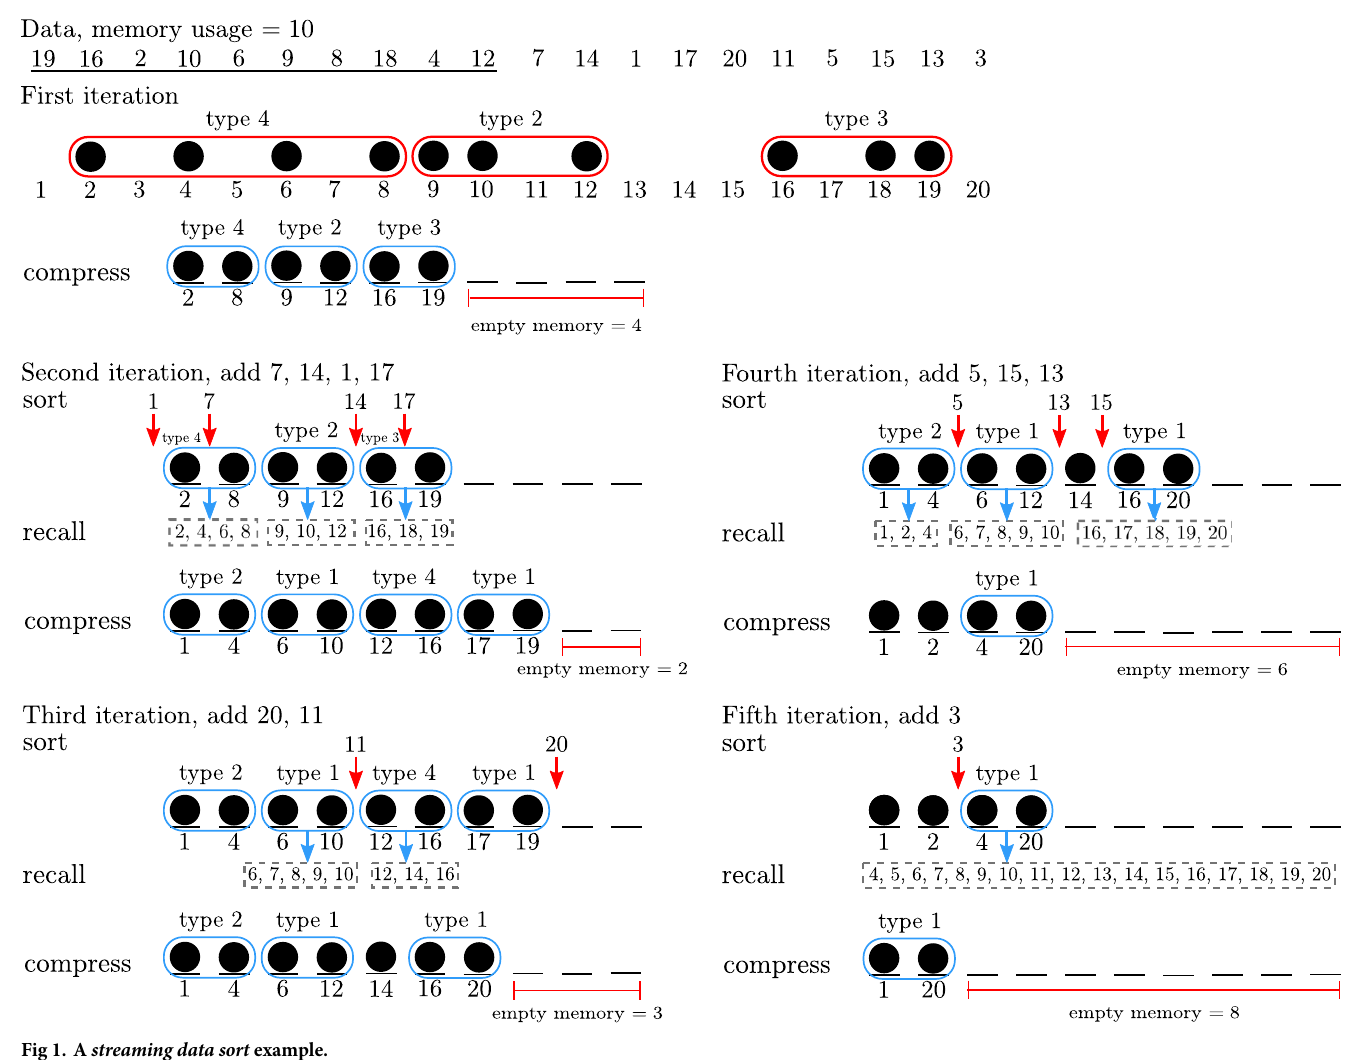
Fig 1. A streaming data sort